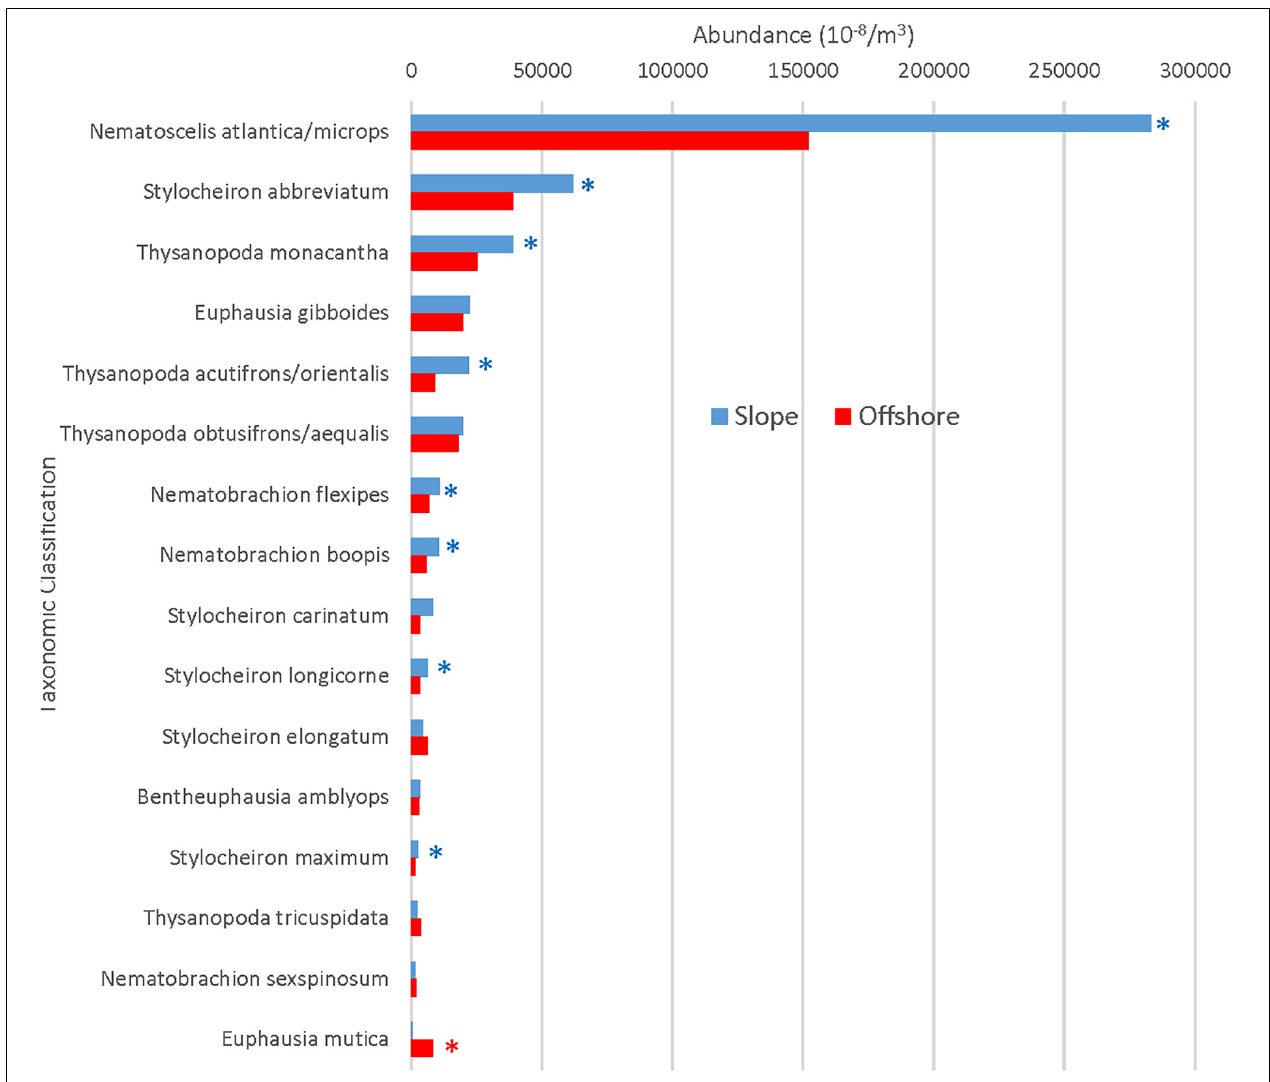
FIGURE 4 | Slope and offshore standardized abundances for abundant species. Asterisks indicate significantly greater abundances for slope (blue) or offshore (red) locations. Species are arranged from maximum to minimum abundances at slope